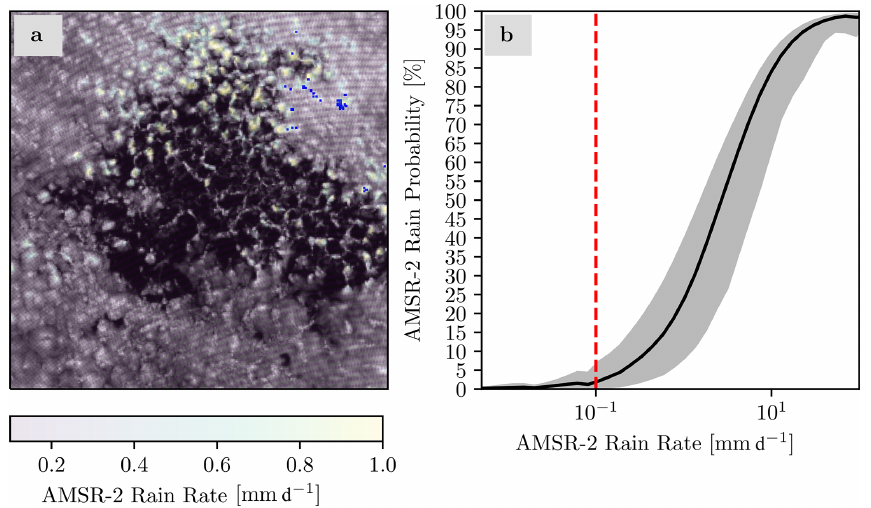
Figure 4. Advanced Microwave Scanning Radiometer 2 (AMSR-2) rain rates matched to the POC shown in Fig. 2 overlaid on GOES-16 0.64µm reflectance are shown in panel (a) . AMSR-2 rain probability as a function of rain rate for all September–November 2019 data over the entire domain are shown in panel (b) , where the solid black line represents the median probability at a given rain rate, gray shading represents the 10–90th percentile spread at a given rain rate, and the dashed red line represents the rain rate threshold of 0.1mmd − 1 .